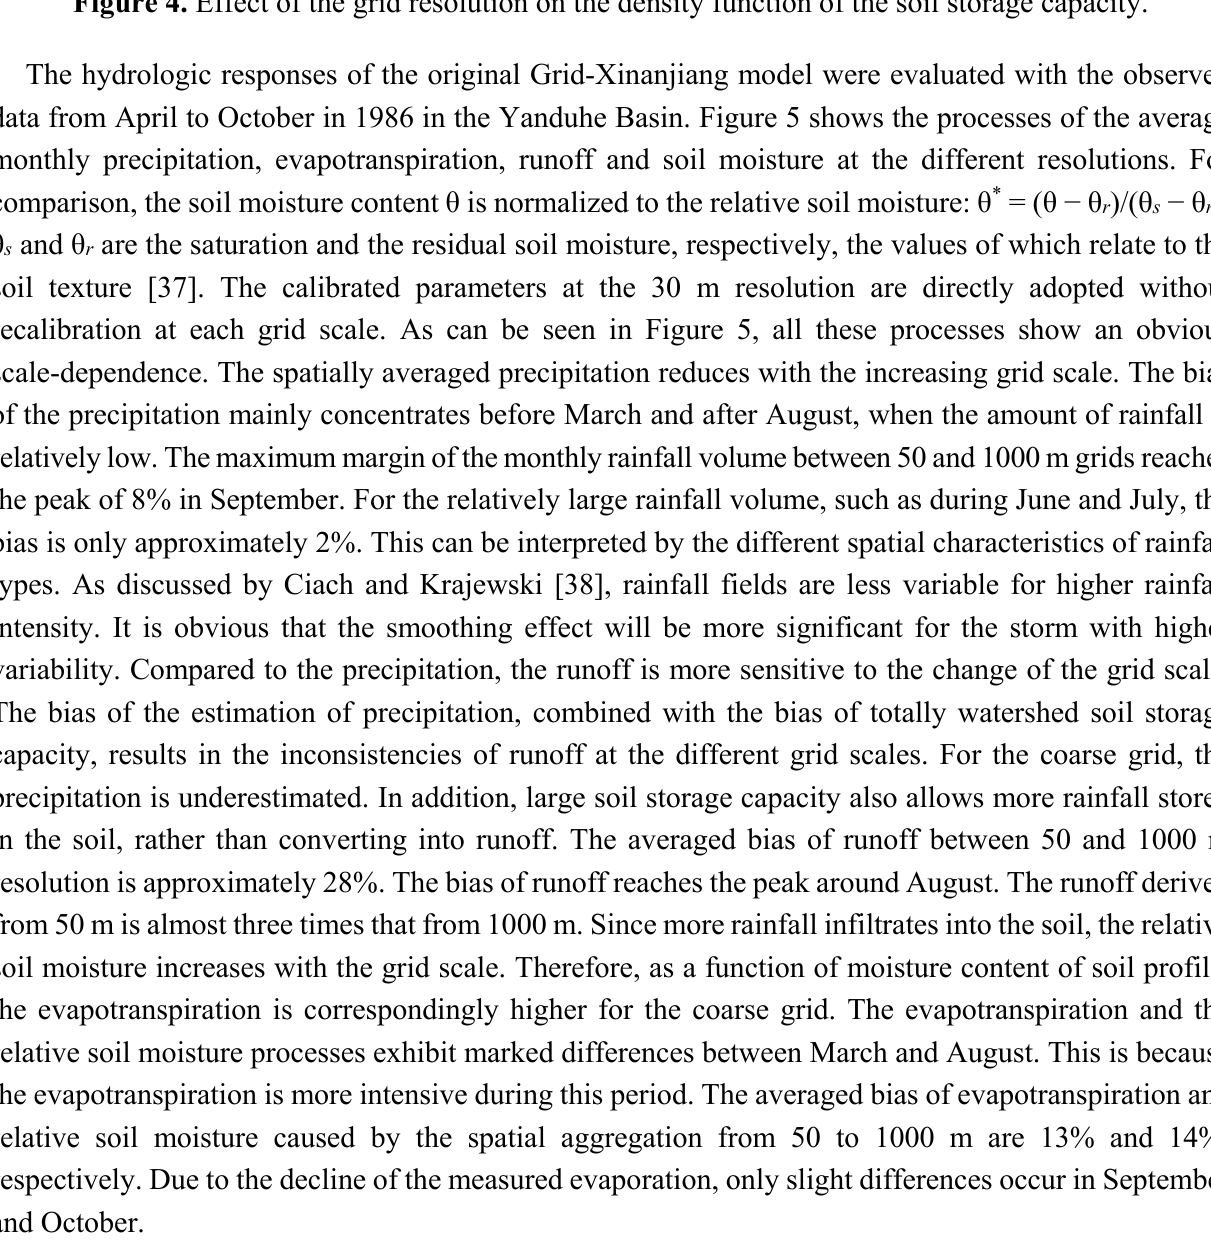
Figure 4. Effect of the grid resolution on the density function of the soil storage